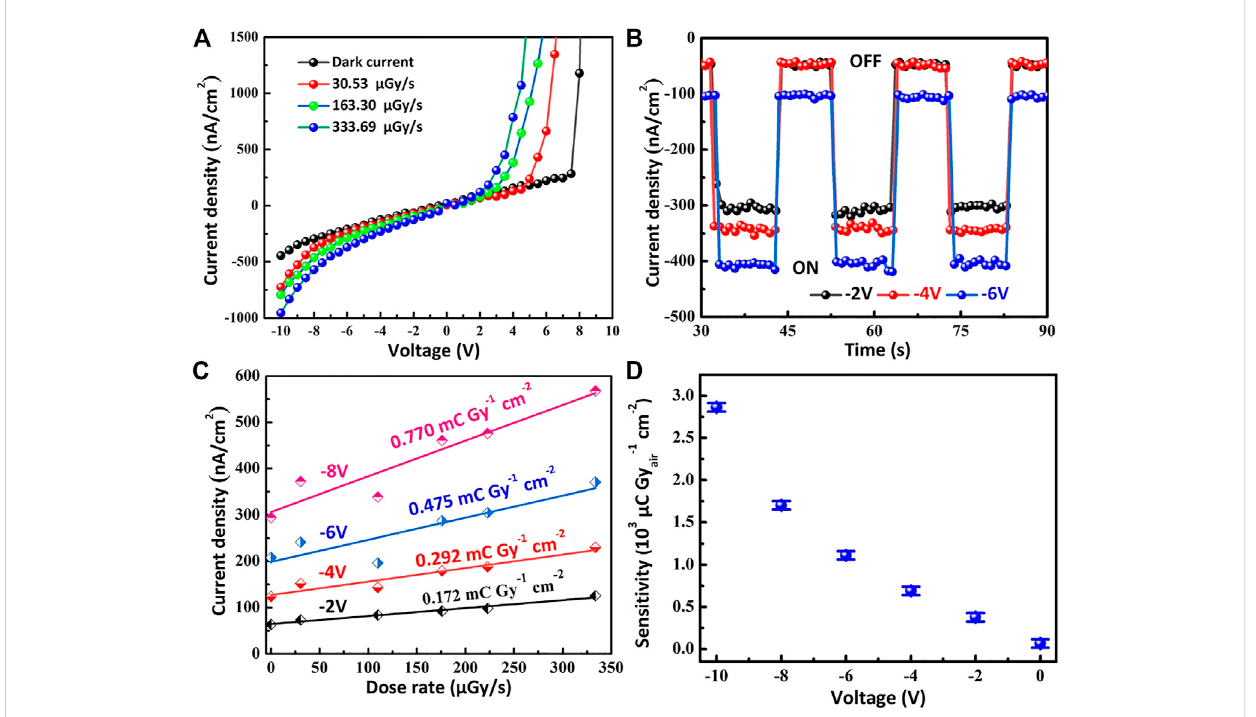
FIGURE 8 (A) I − V curve of CsPbBr 3 SCs devices under various X-ray dose rates (30.53, 163.30, and 333.69 μ Gy/s). (B) On and off photocurrent density of CsPbBr 3 SCsdeviceswithdifferentbiasesapplied( − 2, − 4,and − 6 V)andirradiatedbya45 keVX-ray. (C) PhotocurrentresponseofCsPbBr 3 SCsdevicesat different reverse biases under 40 keV X-ray various dose rates. (D) Sensitivity versus bias of CsPbBr 3 SCs devices under a 45 keV X-ray at the dose rate of 333.69 μ Gy/s. Reproduced with permission from Ref.